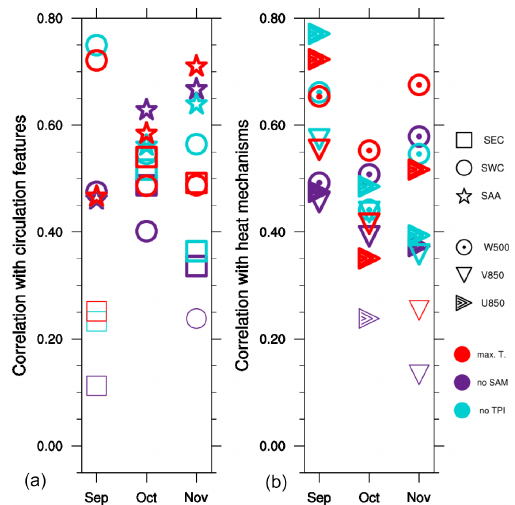
Figure 7. Correlations between Australian area-averaged maxi- mum temperature (red) between key atmospheric circulation fea- tures (a) and dynamical heating mechanisms (b) for September, Oc- tober, and November. The purple and turquoise show partial corre- lations of the same but with the SAM and tropical TPI linearly re- moved. Bold lines show the correlation was statistically significant at the 95% confidence level using Student’s t test with 39